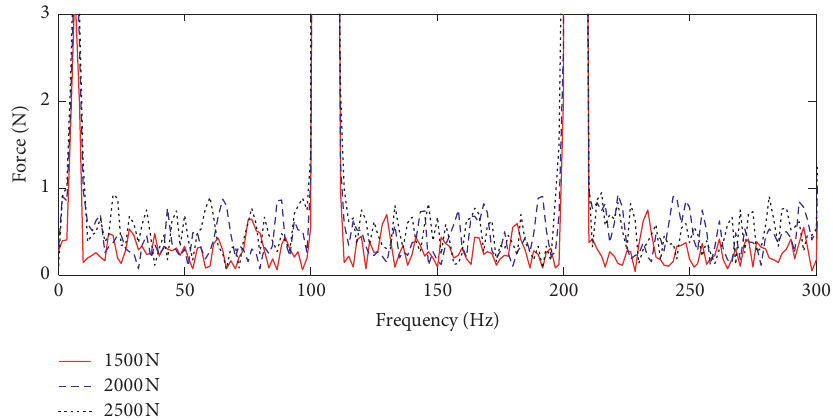
Figure 17: Meshing force spectrum of s- p